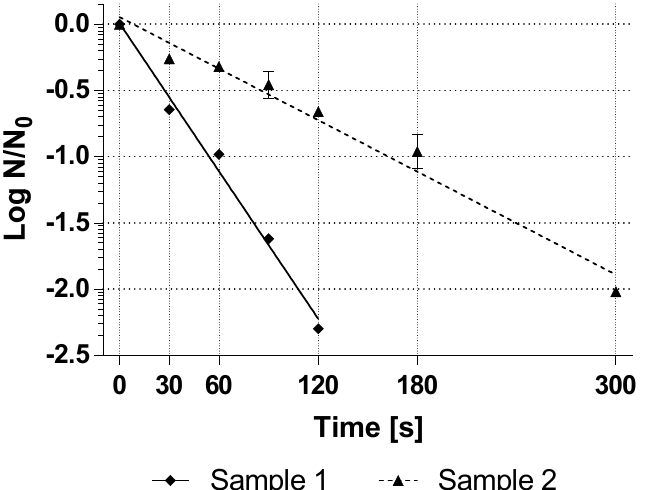
Figure 3. Inactivation curves with treatment with 35% hydrogen peroxide at 25 °C (technical triplicate) of BI samples of G. stearothermophilus (ATCC 7953) spores in suspension from two different batches of the same BI manufacturer. Some error bars are smaller than the symbols and thus not visible.